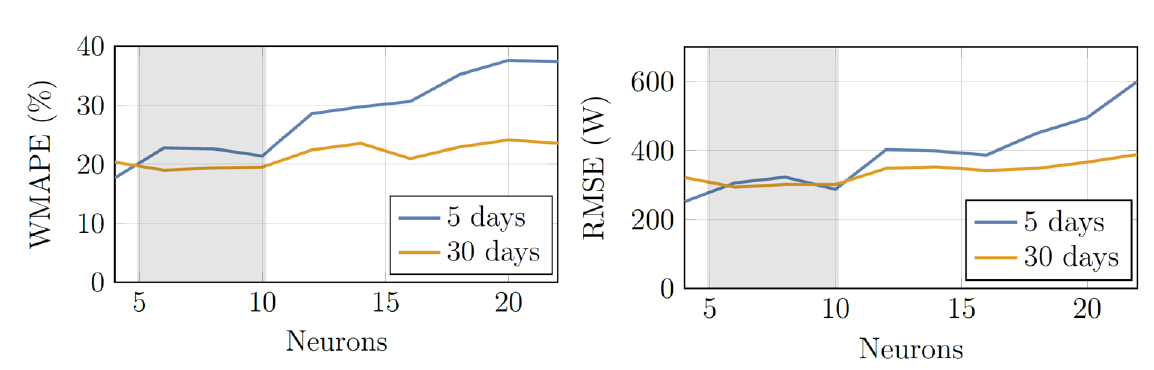
Figure 14. Weighted Mean Absolute Percentage Error (on the left) and Root Mean Square Error (on the right) referred to 5 and 30 days training sets for different numbers of neurons (from 4 to 22).